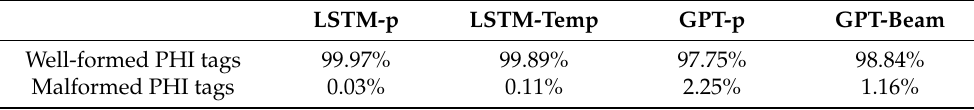
Table 5. A comparison of PHI tag consistency across synthetic